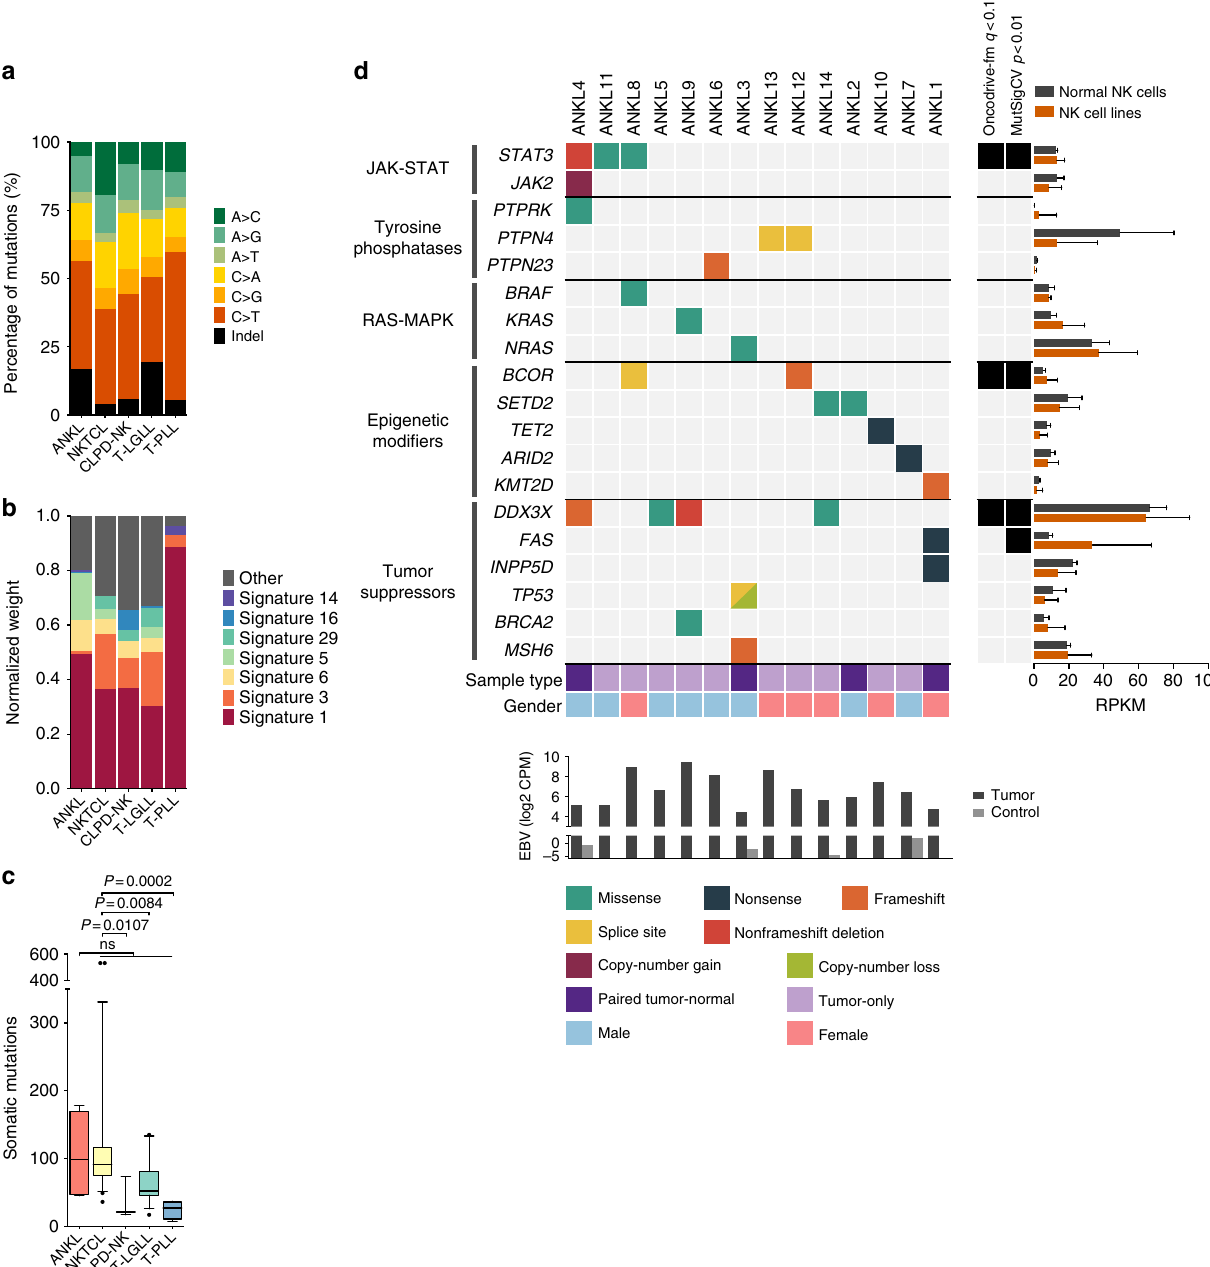
Fig. 1 Whole-exome sequencing in ANKL. a Percentages of somatic base substitutions and indel mutations identi fi ed by whole-exome sequencing in tumor-normal paired samples of ANKL ( n = 4), NKTCL ( n = 25), CLPD-NK ( n = 3), T-LGLL ( n = 15) and T-PLL ( n = 4). Synonymous mutations were included in the analysis. b Normalized weights of trinucleotide signatures identi fi ed using deconstructSigs in tumor-normal paired samples of ANKL, NKTCL, CLPD-NK, T-LGLL, and T-PLL. Weights of three most frequent signatures in each cancer type are shown across cancers as separate signatures and others are included under “ other ” . Synonymous mutations were included in the analysis. c Numbers of somatic mutations in tumor-normal paired samples of ANKL, NKTCL, CLPD-NK, T-LGLL, and T-PLL. Synonymous mutations were included in the analysis. Horizontal lines indicate median, error bars indicate 10th and 90th percentiles, boxes represent interquartile ranges, and dots indicate outliers. P values were calculated using the Mann – Whitney U -test. d Alterations identi fi ed by whole-exome sequencing selected based on recurrence and biological signi fi cance. Complete lists of identi fi ed mutations are found in Supplementary Data 2. Diagonally split dual-colored rectangle indicates the presence of two alterations of different type in the same sample. Reads mapping to the EBV genome are reported as counts per million (CPM) under the fi gure. Results of the MutSigCV and Oncodrive-fm driver gene analyses are presented on the right side of the fi gure. Expression estimates of mutated genes in normal NK cells and NK cell lines are shown on the right as reads per kilobase per million mapped reads (RPKM), with bar length indicating mean and error bars representing